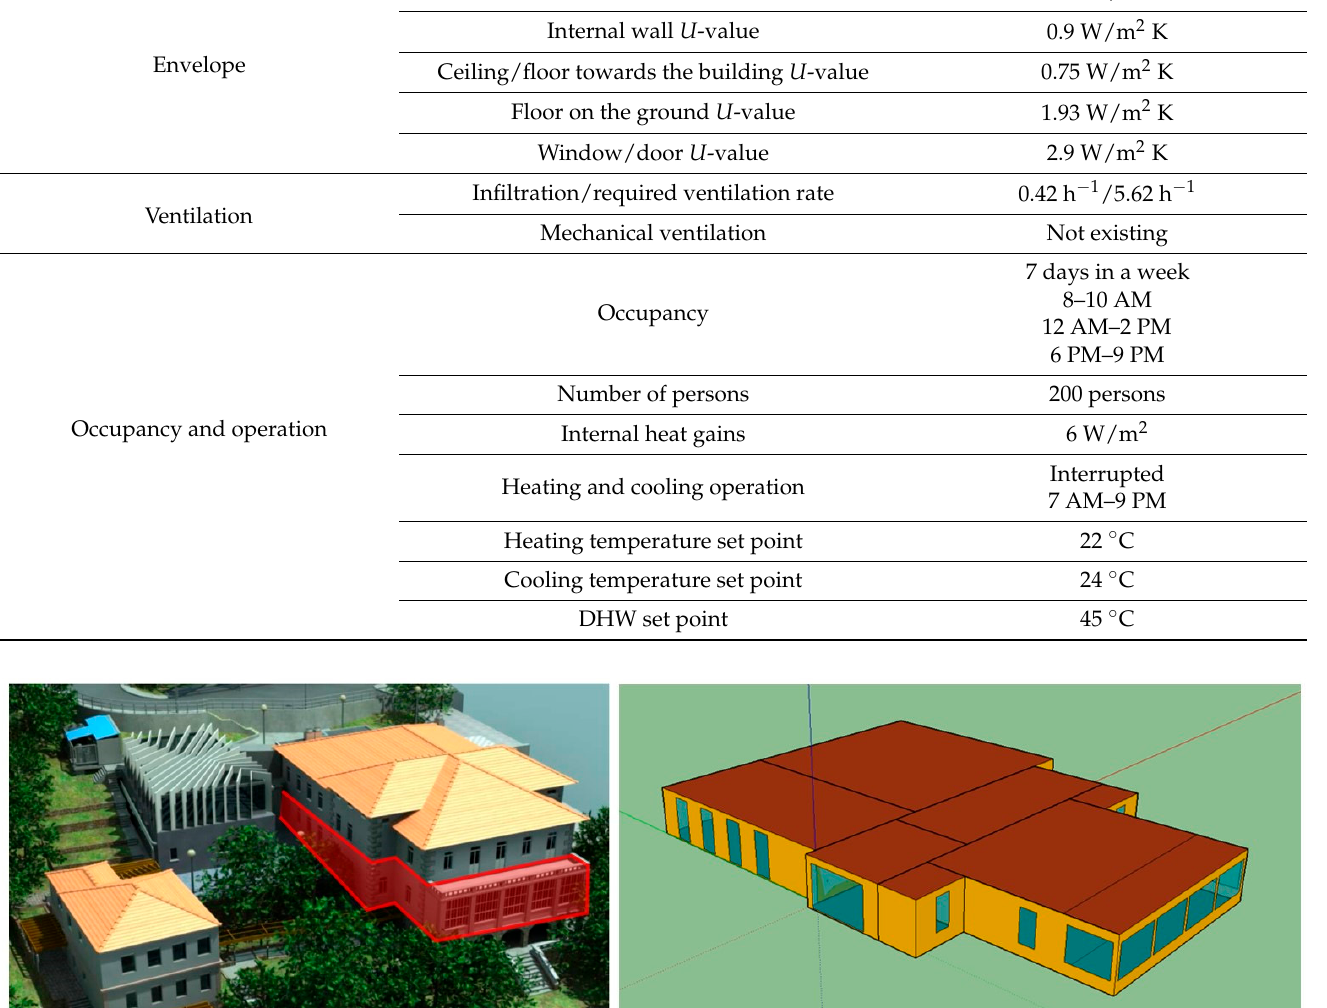
Table 1. Main characteristics of the building regarding physics, operation, and climate data.